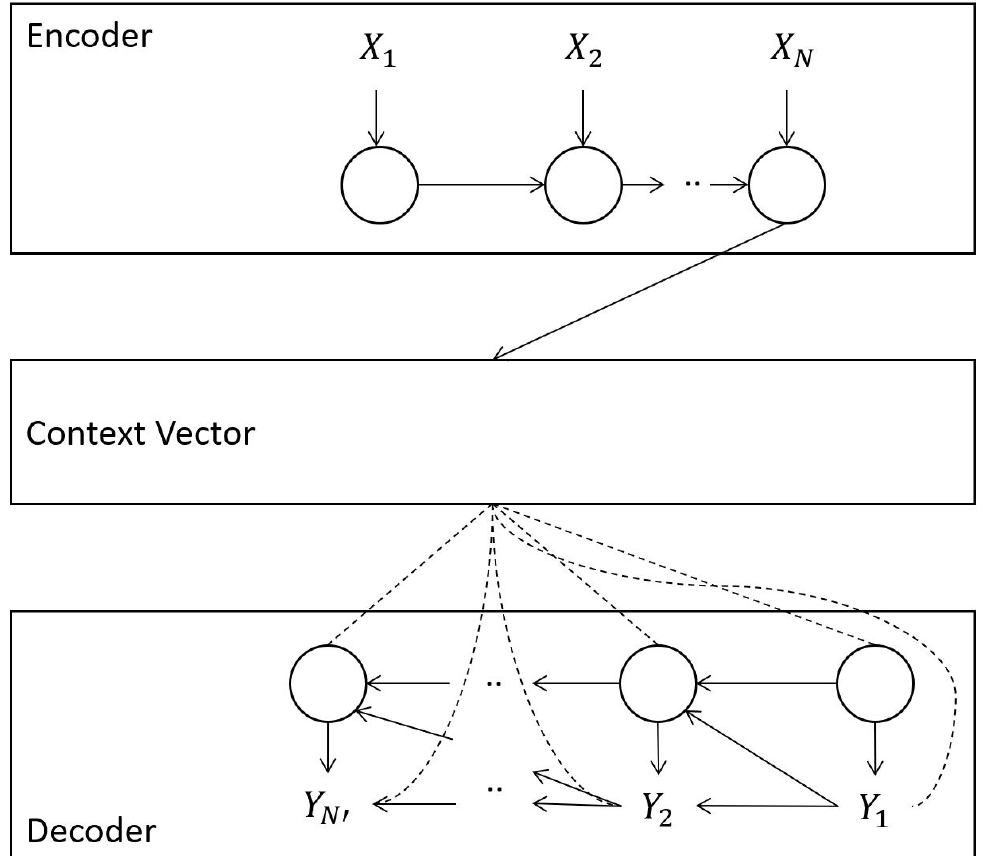
Figure 2. Encoder–decoder model